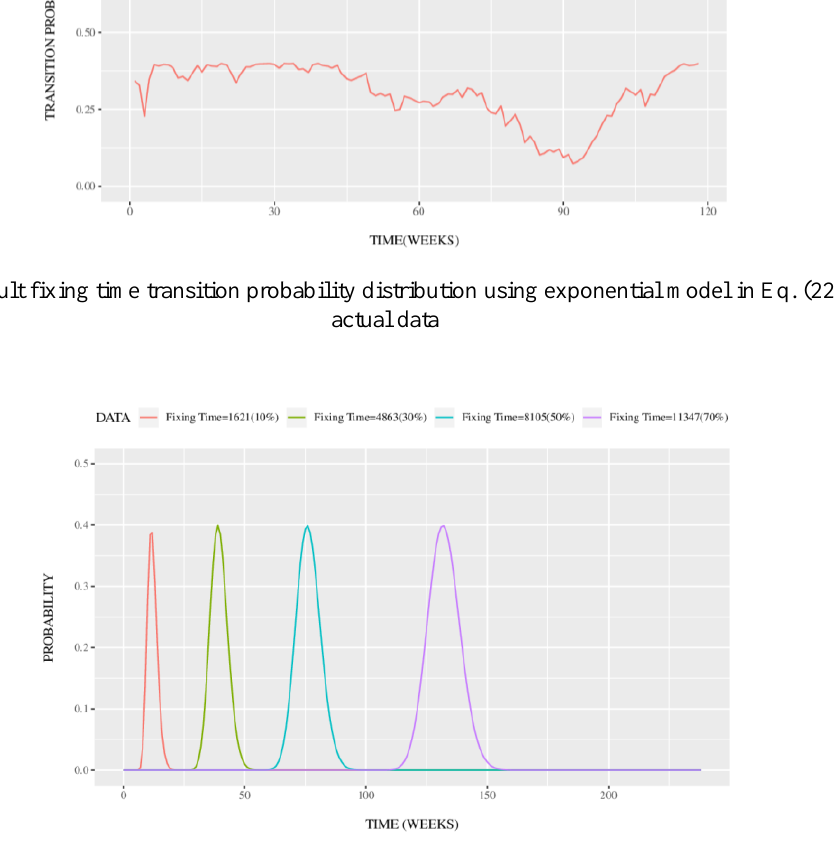
Figure 6. The estimated transition probability distribution using exponential model in Eq.